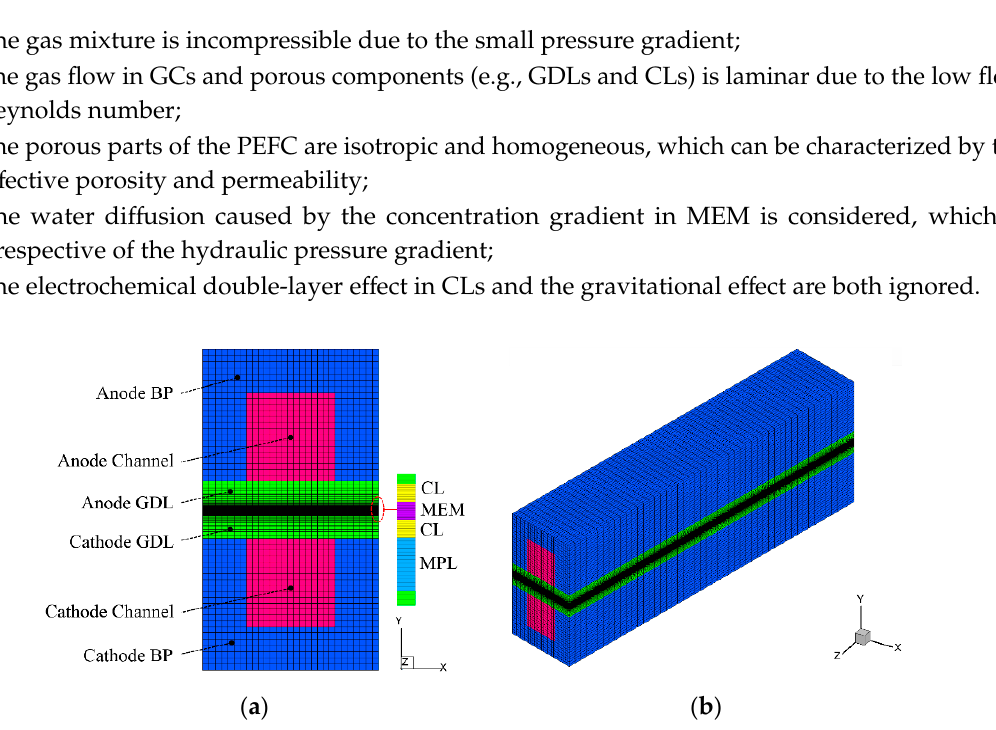
Figure 1. ( a ) Configuration of the Polymer electrolyte fuel cell (PEFC), and ( b ) the computational mesh. Table 1. Geometry and material parameters of the cell [35].